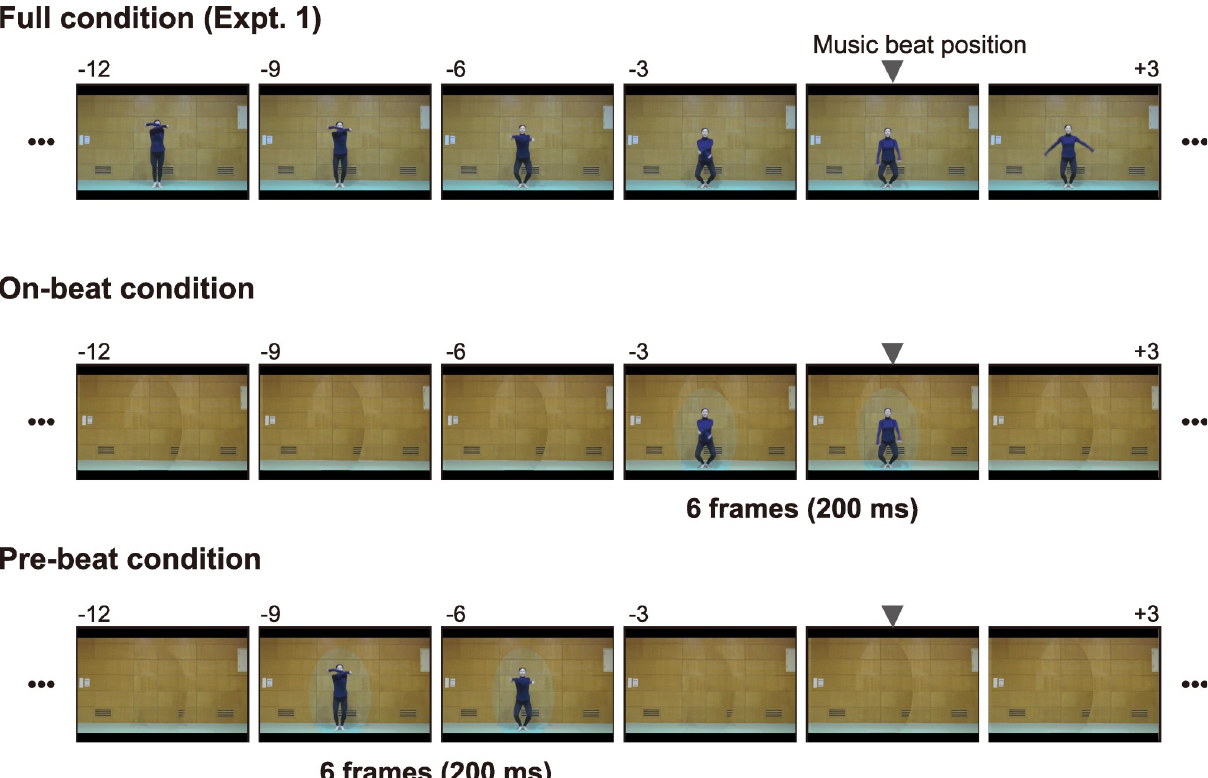
Fig 5. Visual stimuli used in Experiment 2. This figure shows the configuration of the visual stimuli used for Exercise #2 in Experiment 2. In the on- beat condition, visual information about the performer’s motion was provided only in six frames (= 200 ms) around the music beats. In the other frames, the region containing the performer was filled with a static background image. In the pre-beat condition, the performer’s motion was presented in the frames prior to the music beats. The intervals between the adjacent snapshots contain 3 frames (i.e., 100 ms). The visual stimuli for Exercise #8 were presented in the same